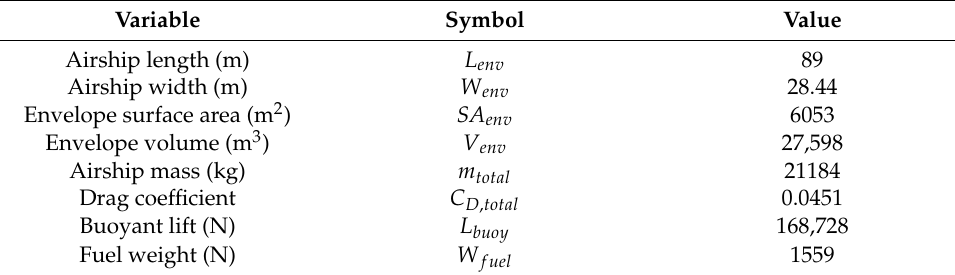
Table 2. Optimal outcome of the baseline